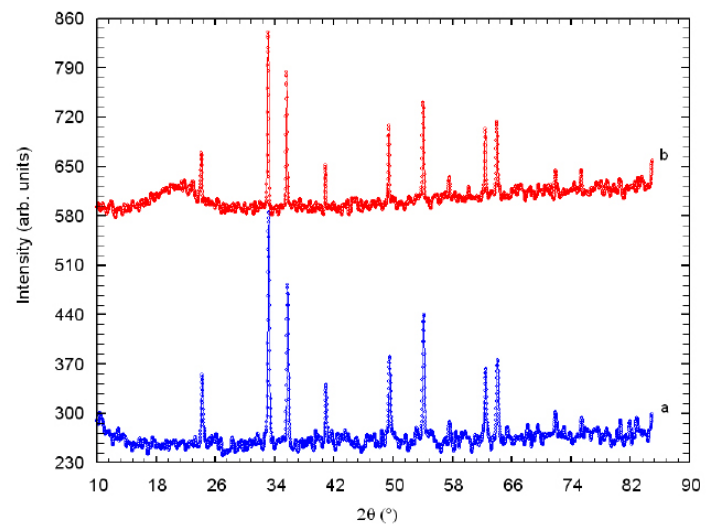
Figure 7. X-ray diffractions patterns of α -Fe